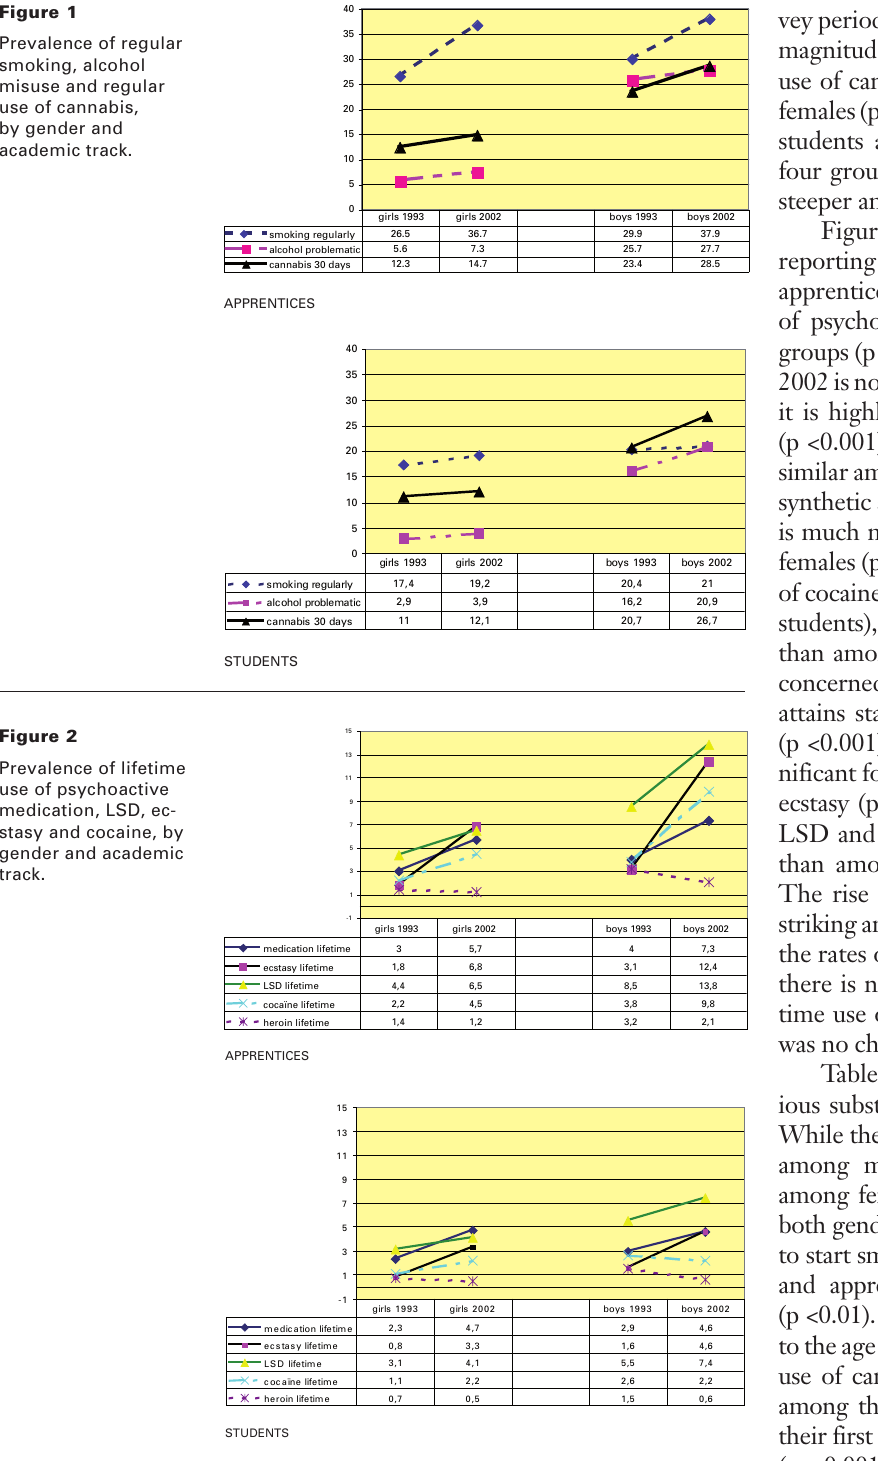
Figure 1 Prevalence of regular smoking, alcohol misuse and regular use of cannabis, by gender and academic track.